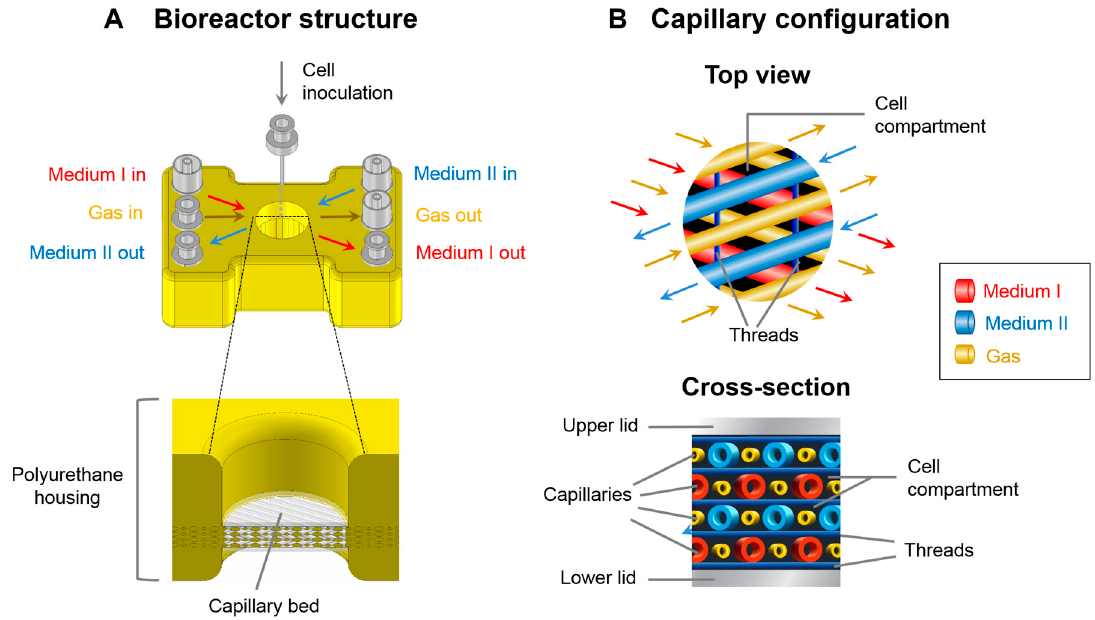
Figure 1. Schematic illustration of the structure of the microscale 3D liver bioreactor. ( A ) Outside view of the bioreactor with tube connections for medium in- and outflow via two independent capillary systems (Medium I and Medium II), perfusion with an air/CO 2 mixture (Gas), and a tube serving for cell inoculation into the extracapillary space (cell compartment); the figure below shows a section of the bioreactor housing with a central cavity containing the capillary bed; ( B ) Capillary structure of the bioreactor shown as top view (upper figure) and cross-section (lower figure). The capillary bed consists of four layers of hollow-fiber capillaries. Cells are seeded in the extra-capillary space (cell compartment). The layers form a 45° angle to each other to enable counter-current medium perfusion of the two capillary systems (red: Medium I, blue: Medium II). Synthetic threads (dark blue) integrated between each layer serve as spacers.